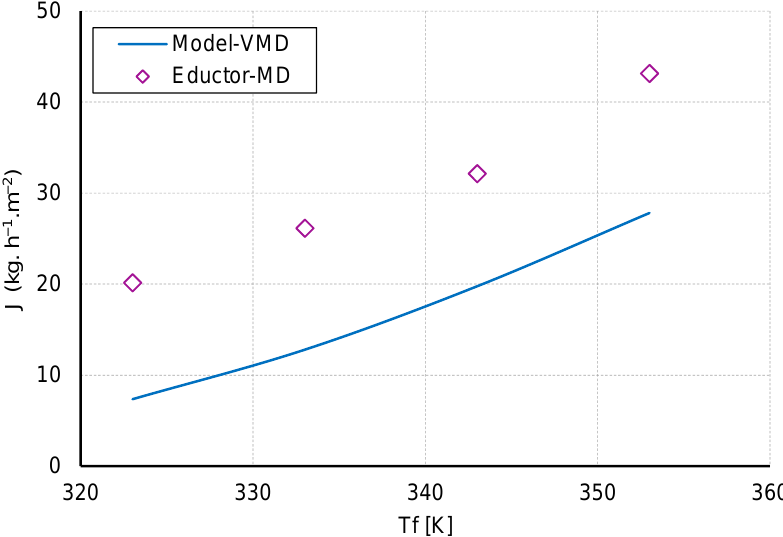
Figure 12. Flux comparison of eductor-based MD with VMD.